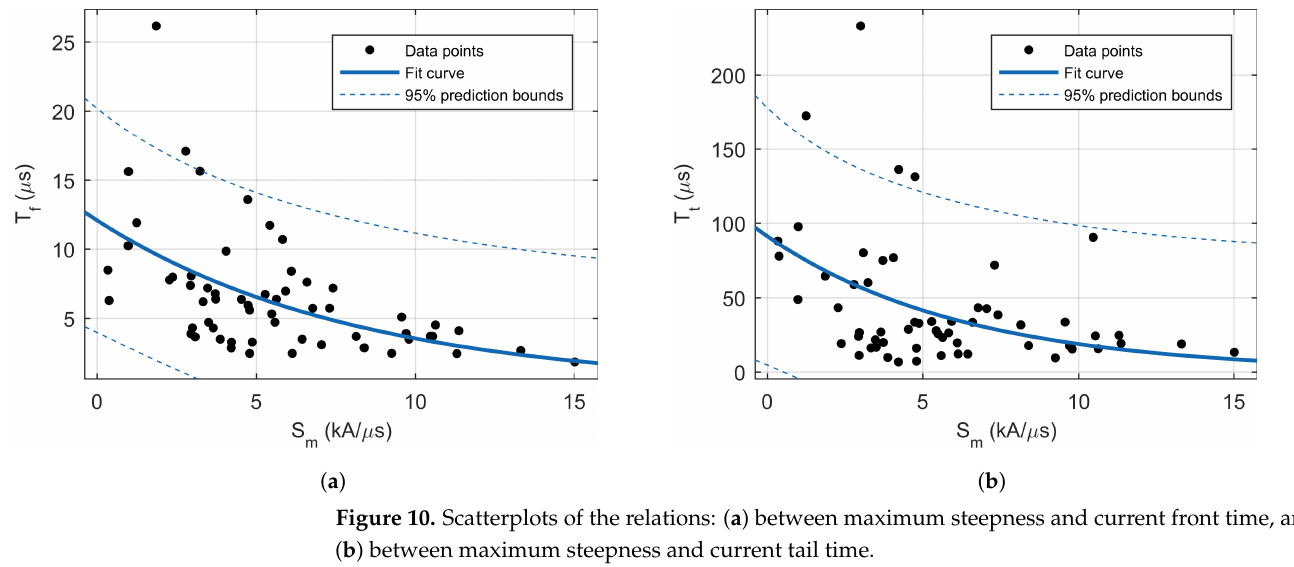
Figure 10. Scatterplots of the relations: ( a ) between maximum steepness and current front time, and ( b ) between maximum steepness and current tail time.